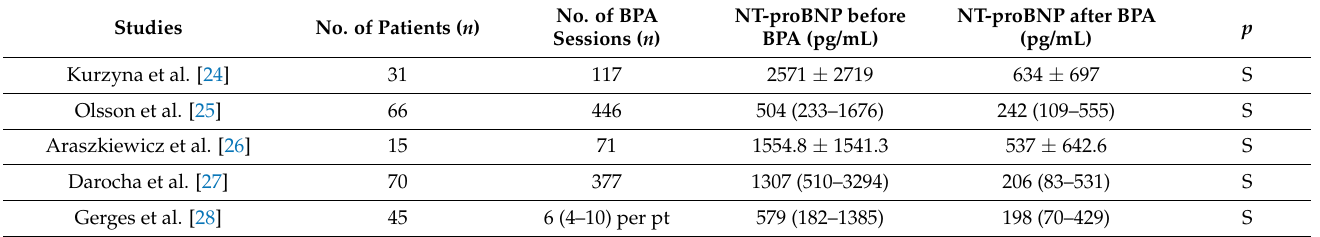
Table 2. Changes in NT-proBNP levels in CTEPH patients before and after BPA treatment in the hitherto published case